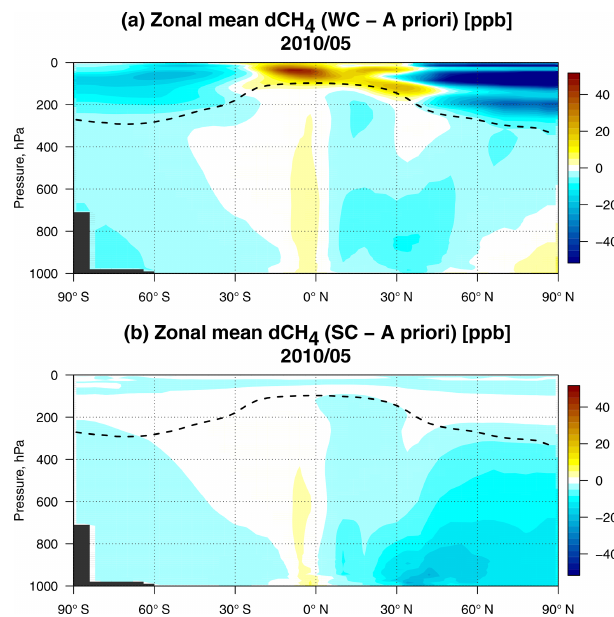
Figure 12. Zonal mean CH 4 differences (in ppb) in May 2010 be- tween (a) the WC_4x5 optimized state and the a priori fields and (b) between the SC_4x5 optimized state and the a priori fields. The dashed line represents the mean monthly tropopause